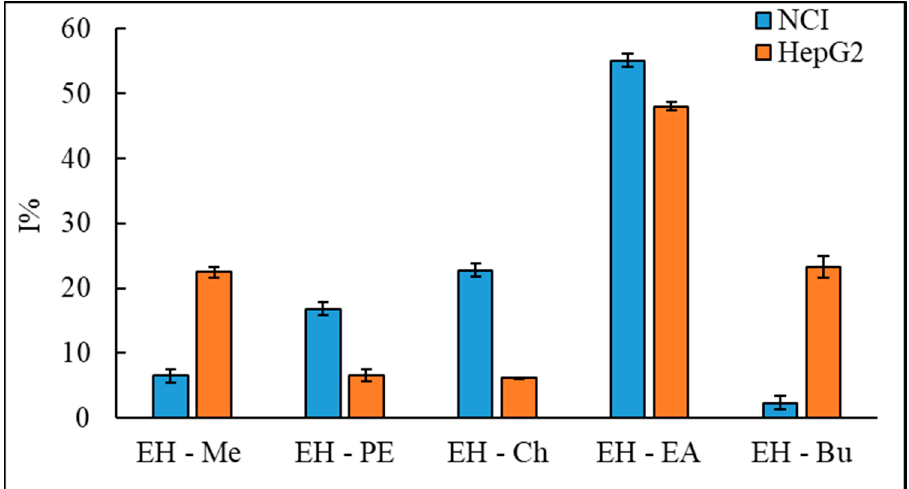
Figure 3. Cytotoxicity of E. hirta L. on NCI H460 and Hep G2 cells.